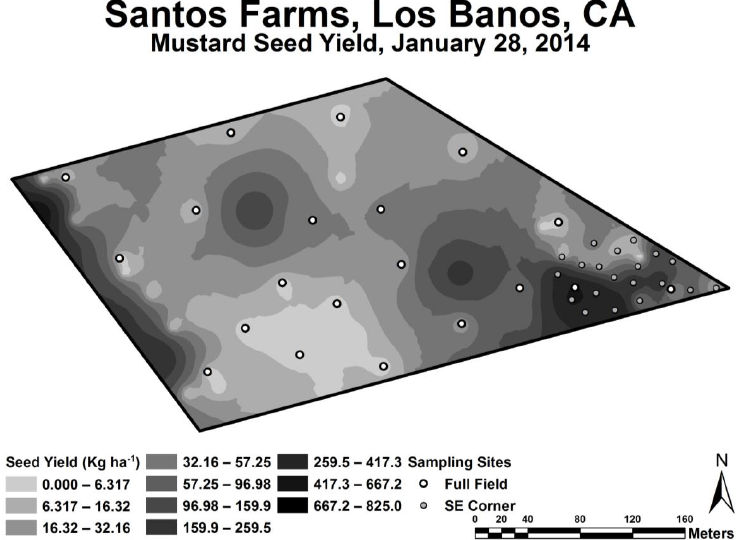
Figure 4. Map of Ida Gold mustard oilseed yield. Oilseed yield sample sites (1 m 2 sample area) are indicated by the clear and filled-in circles. The clear circles are oilseed yield sample sites selected from the full field EC a survey and the filled-in circles are from the SE corner EC a